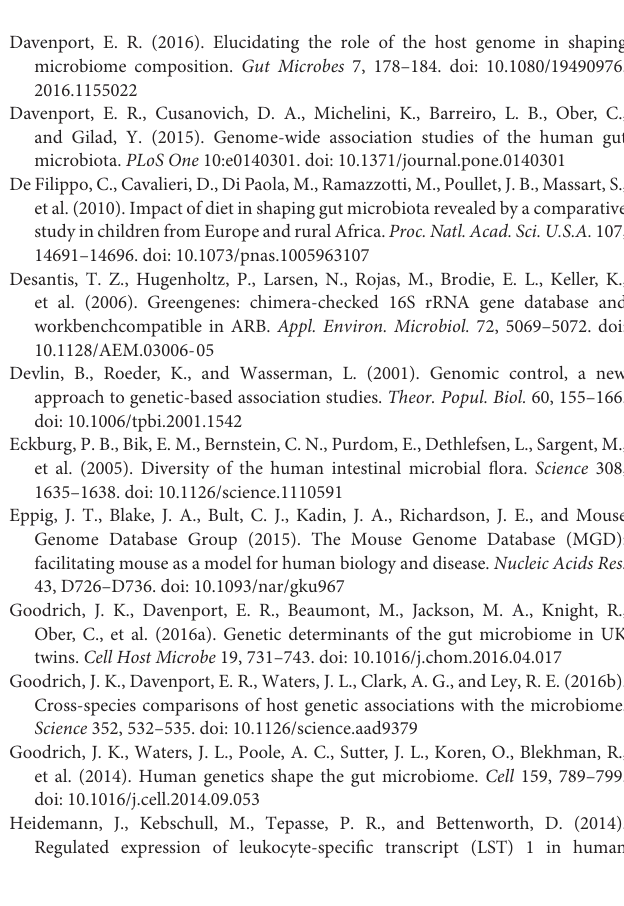
FIGURE S1 | Comparisons of phylogenetic diversity of microbial composition among full-sibs, half-sibs and unrelated individuals by weighted Unifrac analysis using the QIIME (v 1.9). TABLE S1 | Summary of 16S rRNA gene sequencing